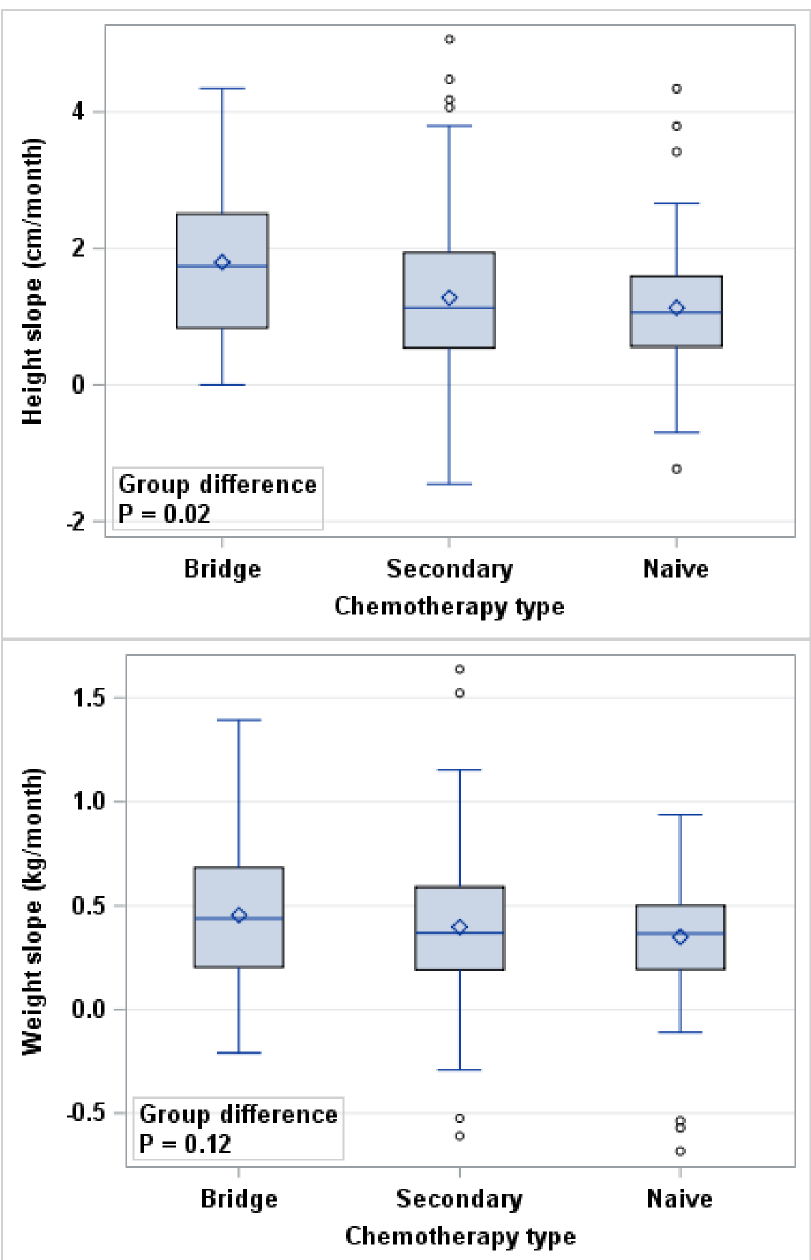
Fig 1. Growth velocity by height and weight during OAC. Growth velocity for height (n = 255) and weight (n = 324) during treatment by chemotherapy group. Growth slope is calculated starting at first treatment and using height and weight measurements up to time of treatment number 4 (or last available measurement prior to treatment 4); slope is calculated for patients who have a measurement available at first treatment and at least one follow-up. Mean height growth is significantly different between groups (ANOVA p = 0.02) with the mean for the bridge group significantly higher than the mean for the naïve group (mean difference: 0.66 cm/month; 95% CI: 0.10, 1.21; p = 0.01). Mean weight growth is not significantly different by group (ANOVA p =